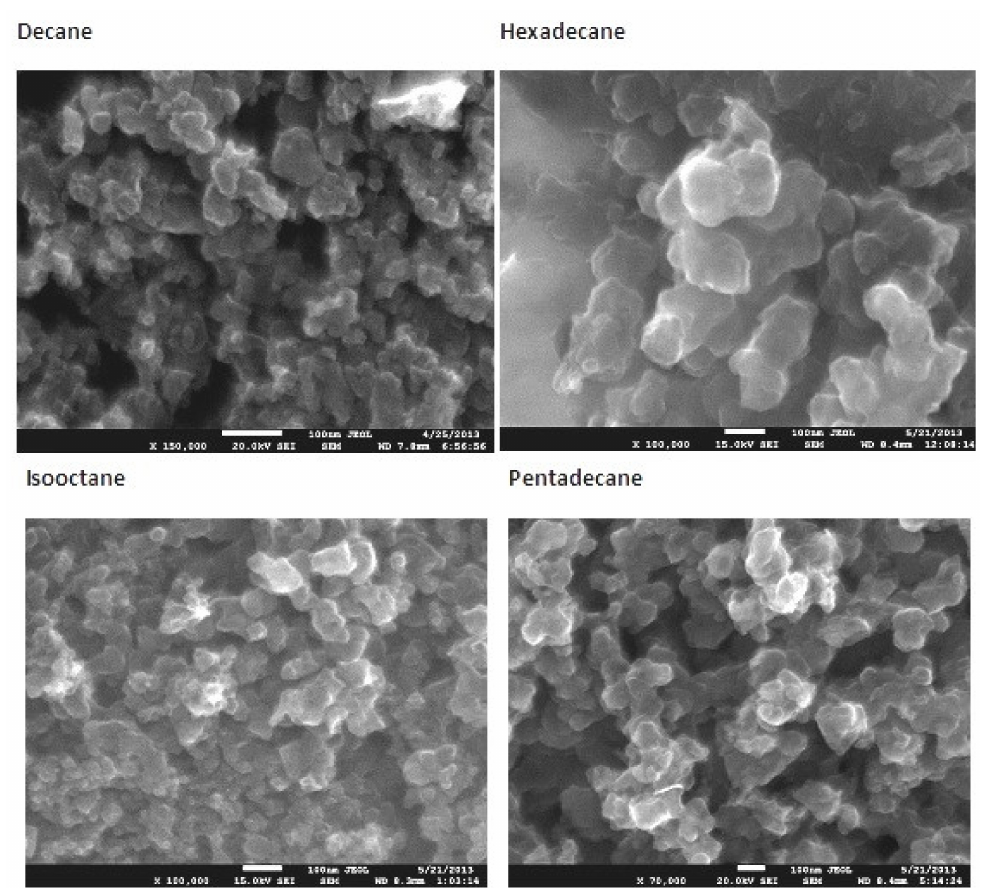
Figure 8. SEM micrographs of the solid products of microwave plasma in different liquid